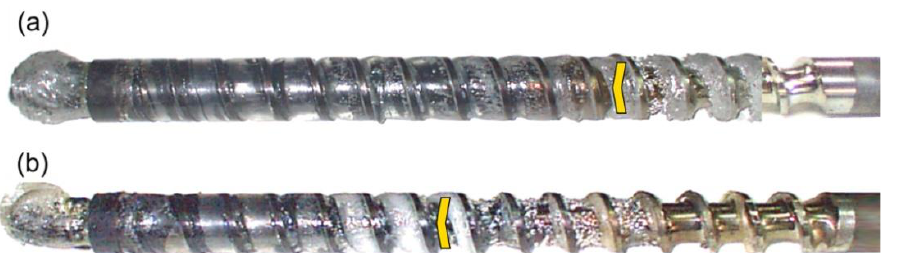
Figure 11. An effect of the plastication stroke on the polymer flow in the injection molding process at the screw speed N = 100 rpm, and the back pressure P back = 0 MPa: ( a ) h plast = 1 D, ( b ) h plast = 3 D.